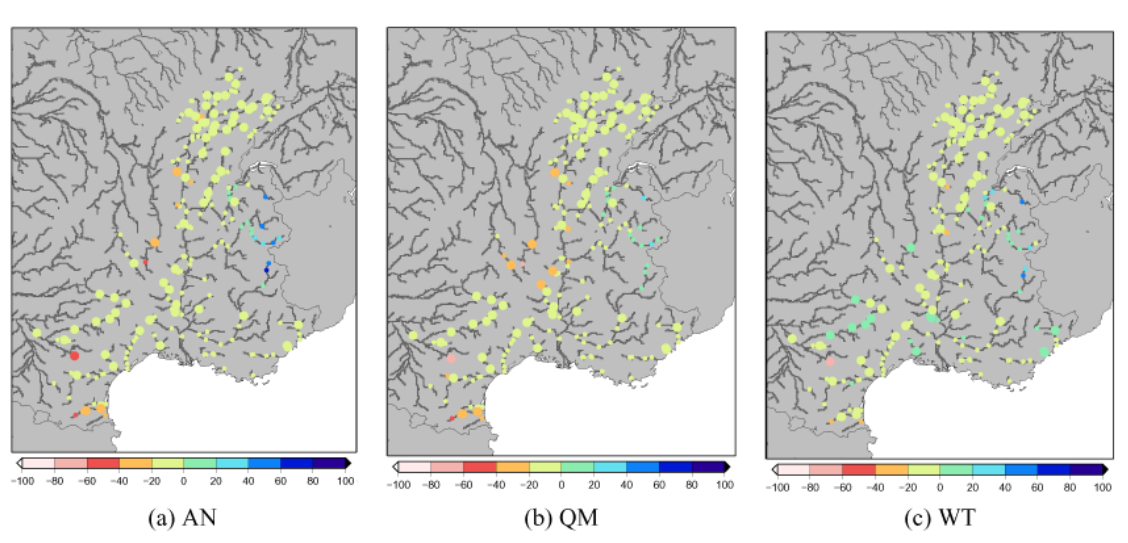
Fig. 16. Anomalies (2035–2064 vs. 1970–2099) of QMNA5 (in